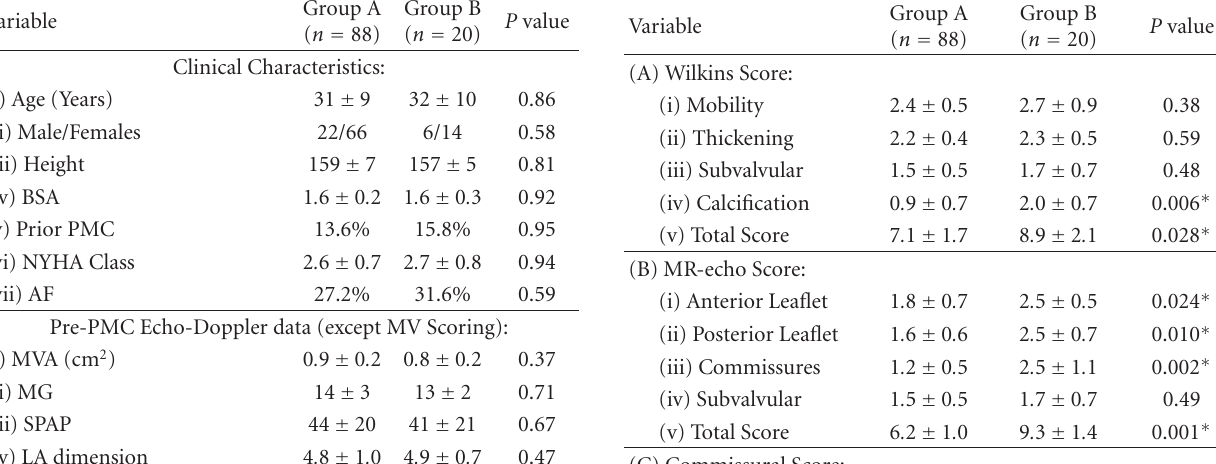
Table 1: Baseline Characteristics. Variable